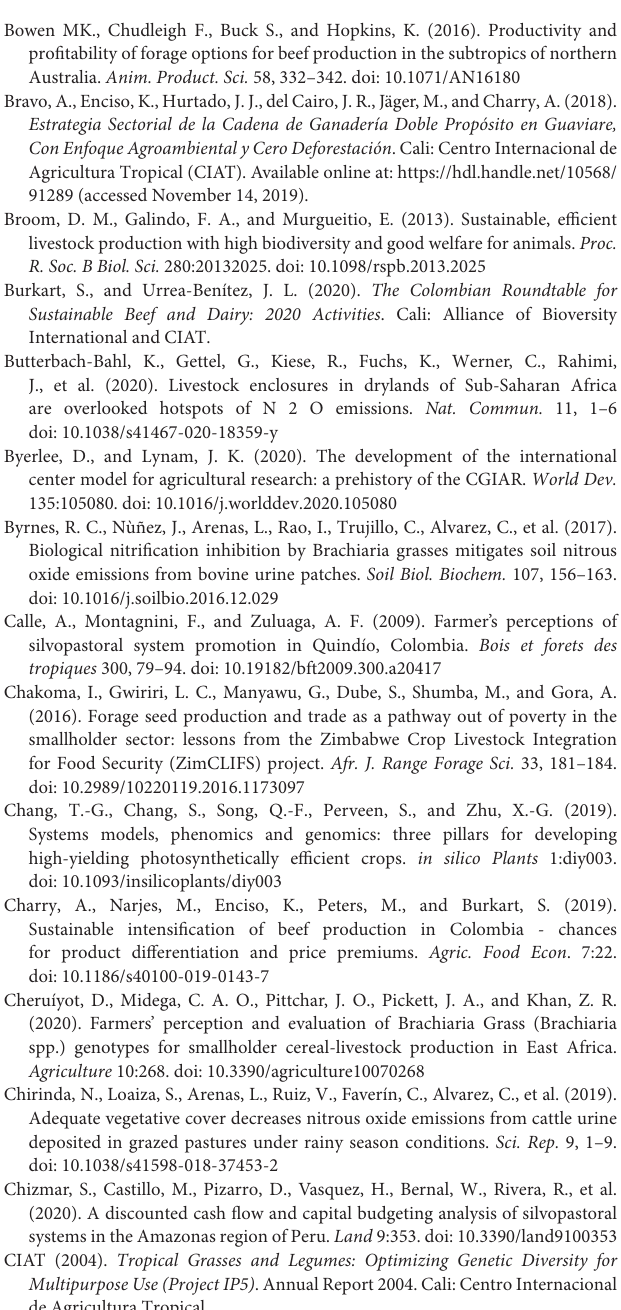
(2020). A discounted cash flow and capital budgeting analysis of silvopastoral systemsin the Amazonas region of Peru. Land 9:353.doi: 10.3390/land9100353 CIAT (2004). Tropical Grasses and Legumes: Optimizing Genetic Diversity for MultipurposeUse(ProjectIP5) .AnnualReport2004.Cali:CentroInternacional de Agricultura